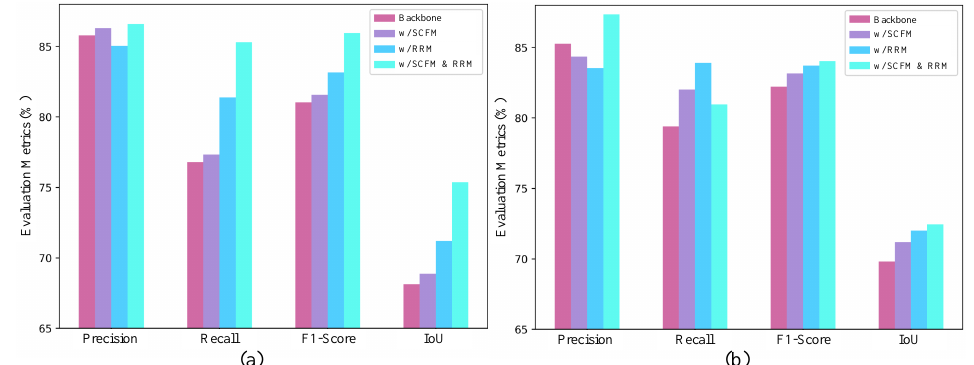
Figure 9. The performance comparison of the combination of different modules on different evalua- tion indicators for two data sets. ( a ) Wenzhou data set and ( b ) Guangzhou data